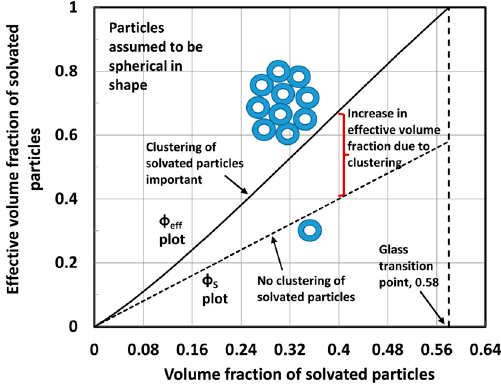
Figure 8. Influence of clustering of solvated particles on the effective volume fraction of dispersed-phase.